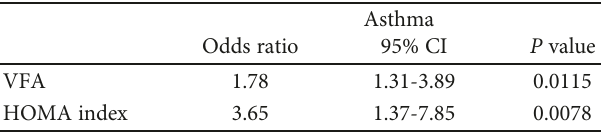
Table 3: Multivariate logistic regression analysis, with asthma as the dependent variable, in patients with type 2